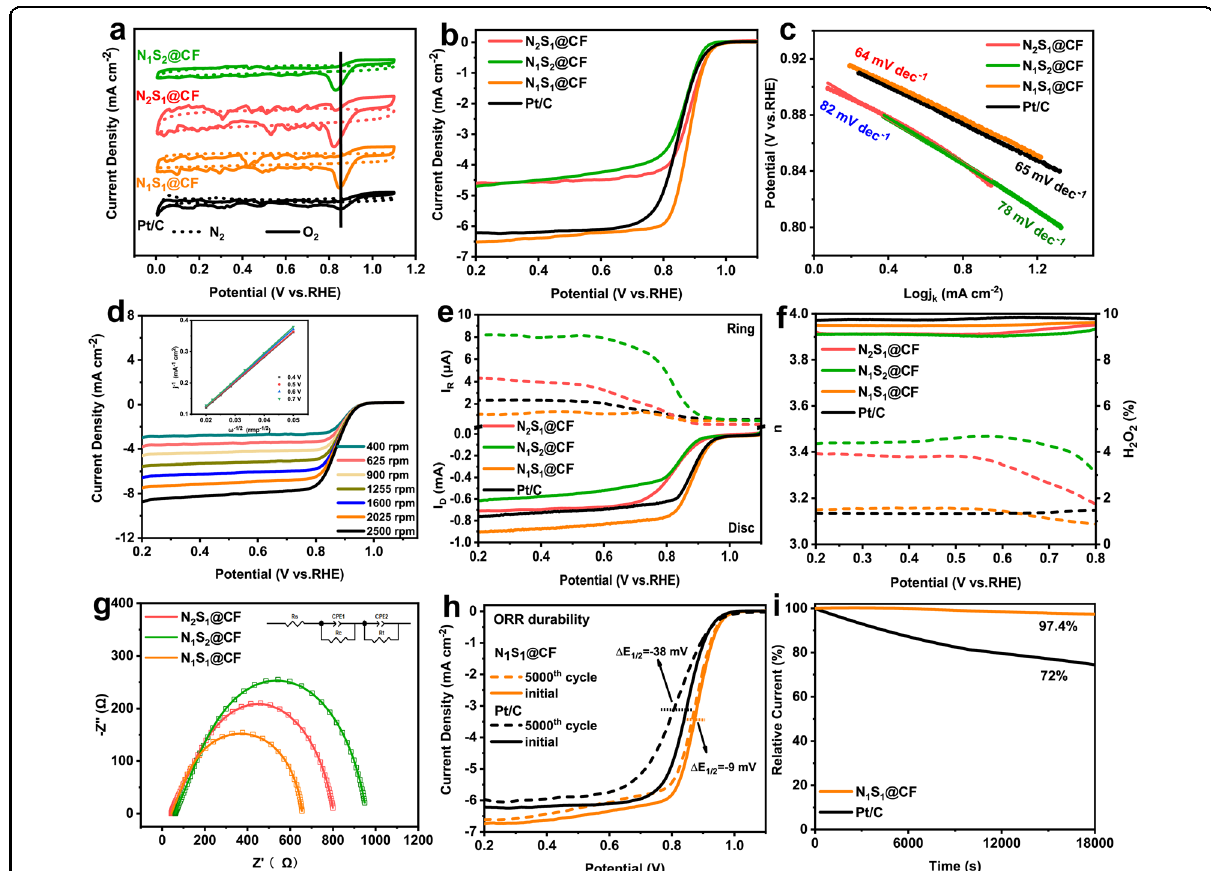
Fig. 3 Electrocatalytic performance of carbon frameworks. a CV curves under N 2 and O 2 . b ORR polarization curves. c Tafel curves for various catalysts. d LSV curves for N 1 S 1 @CF at different scan rates. The illustration indicates the K-L curves for different potentials. e RRDE measurement curves. f Corresponding n and H 2 O 2 % values for various catalysts. g Impedance curve and equivalent circuit diagram. h LSV curves for the ORR before and after 5000 CV cycles. i Durability of the catalyst for the